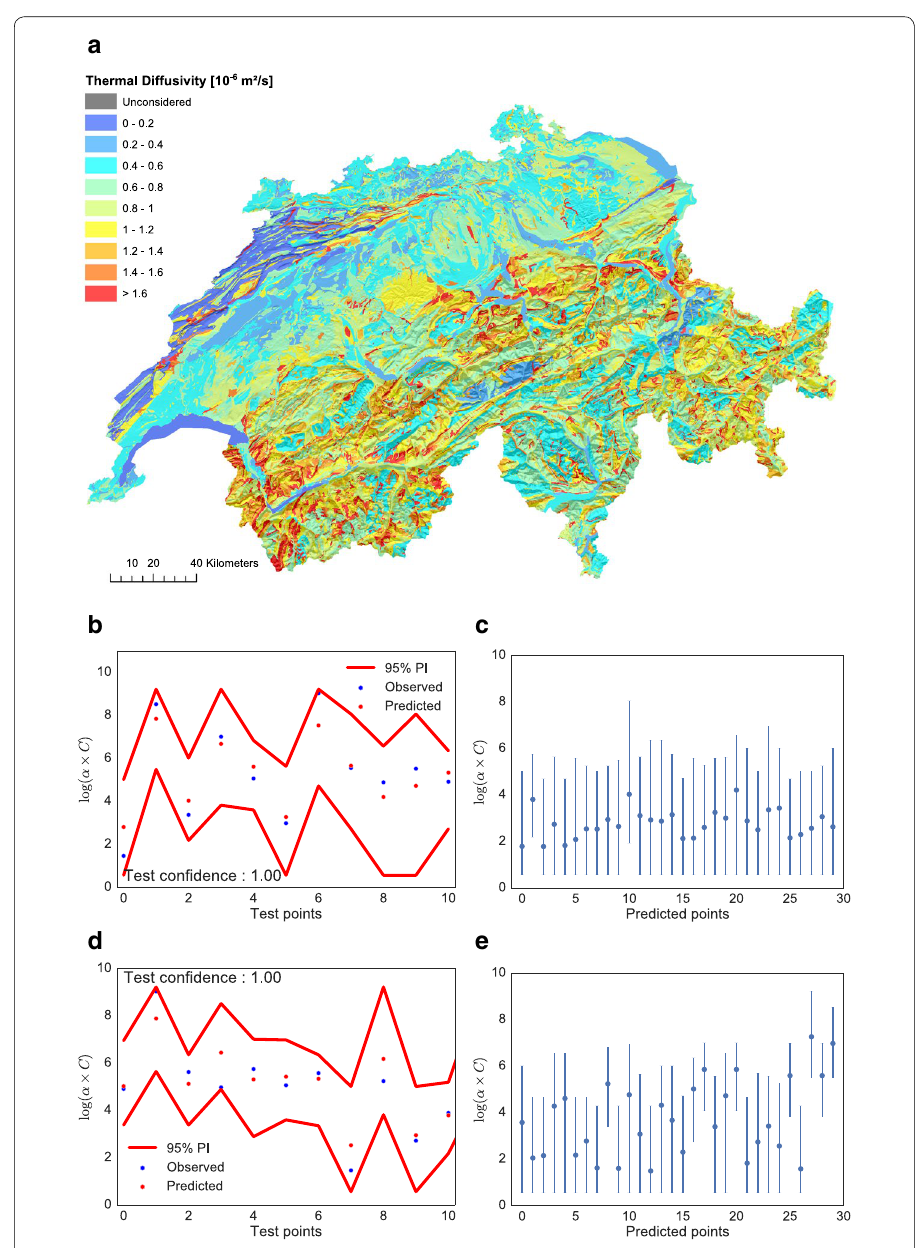
Fig. 16 Thermal diffusivity map as estimated in the study with visualization of PIs (with 95% confidence) both in the test set and for new points. a Thermal diffusivity ( α ) map; b PIs in the test set for the label variable C ) ) while training the RF model, with soil texture features considered; c PIs for 30 random used ( log (α × unknown points for the same label variable, with soil texture features considered; d PIs in the test set for the C ) ) while training the RF model, without soil texture features; e PIs for 30 random label variable used ( log (α × unknown points for the same label variable, without soil texture